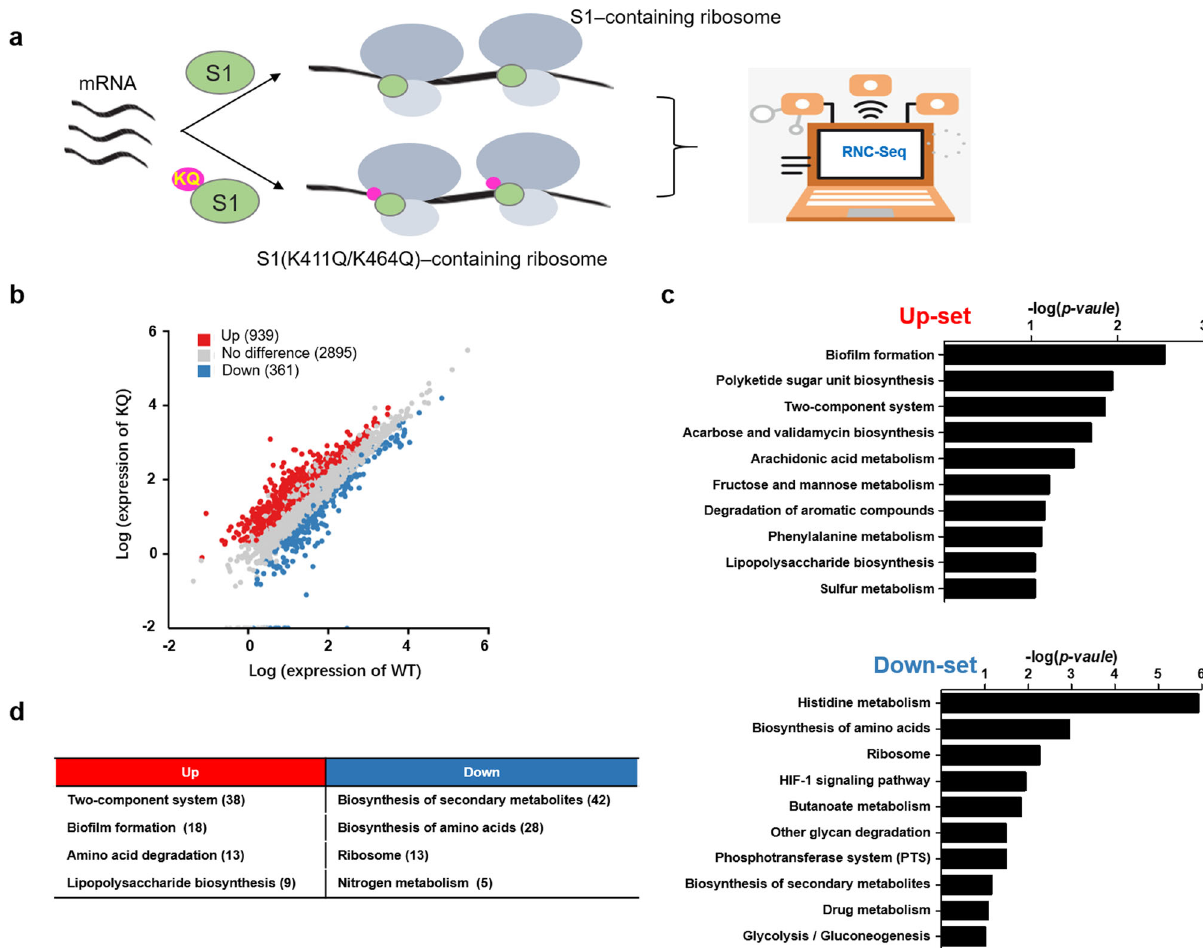
Fig. 2 Acetylated S1 preferentially recruits different subpools of mRNAs to ribosomes. a Schematic of the ribosome-nascent-chain-complex sequence (RNC-Seq) of acetyl-mimetic S1 (K411Q/K464Q) or WT-S1-containing ribosomes. b Scatterplots for differentially expressed genes (up, red; down, blue.) in KQ/WT- RNC-Seq ( p < 0.05). c KEGG pathway-based cluster analysis of KQ/WT-RNC-Seq upregulated genes and downregulated genes from b . d Signi fi cantly enriched KEGG pathways ( P < 0.001) among Up-set or Down-set transcripts in KQ/WT-RNC-Seq. The key KEGG pathways are shown, and the number of associated genes in each KEGG pathway is shown in